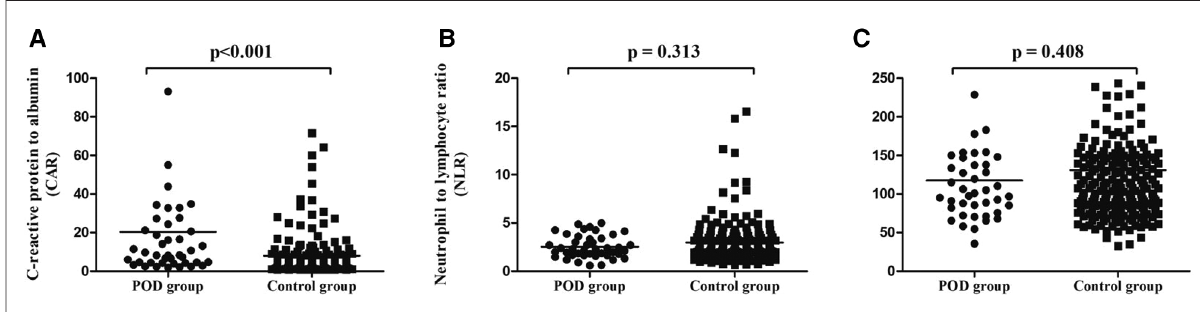
TABLE 2 Correlations of clinical parameters and CAR, NLR and PLR with laboratory measurements in POD